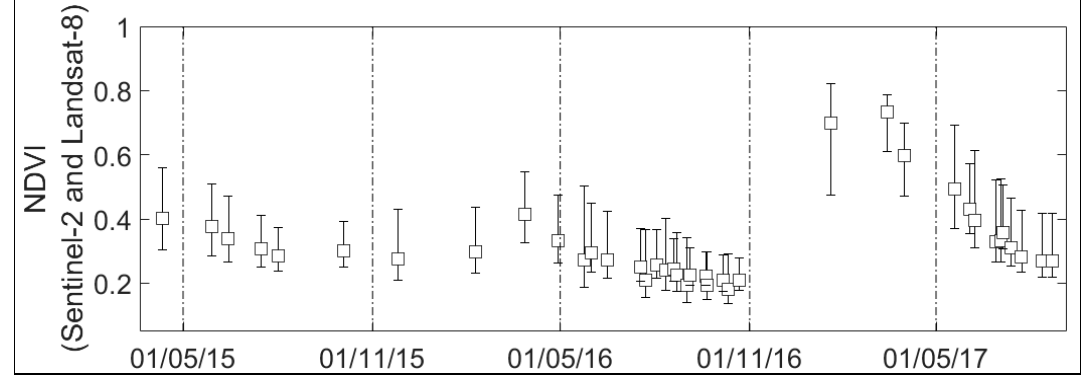
Figure 8. NDVI box plots of time series derived from Sentinel-2 and Landsat-8 for the entire study